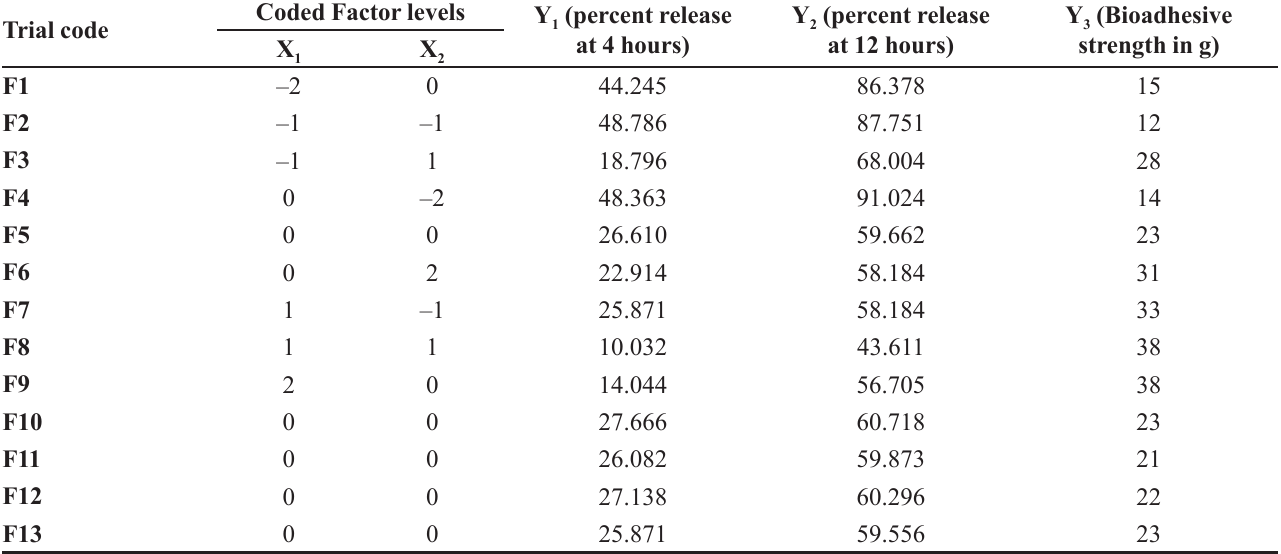
TABLE V - Formulations according to the central composite design with observed responses Trial code